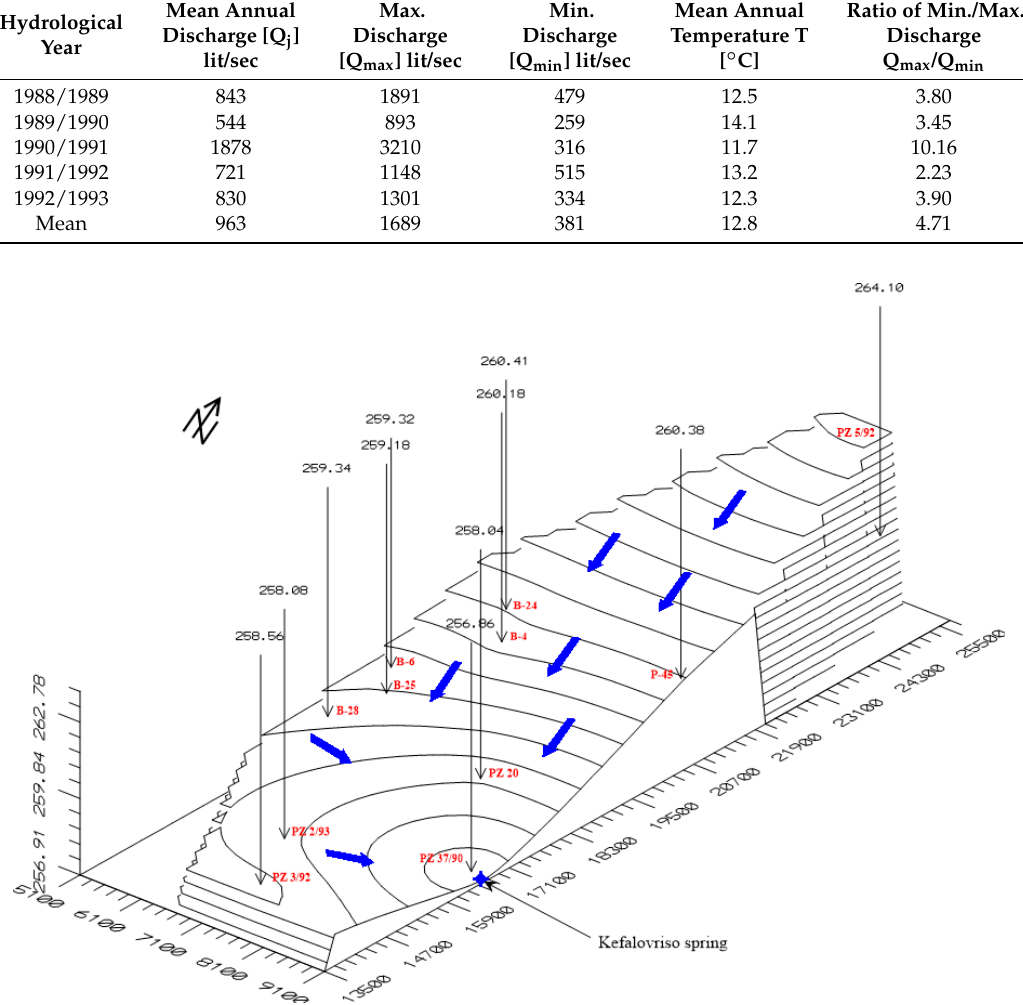
Figure 3. Three-dimensional (3-D) piezometric map of the karst aquifer.